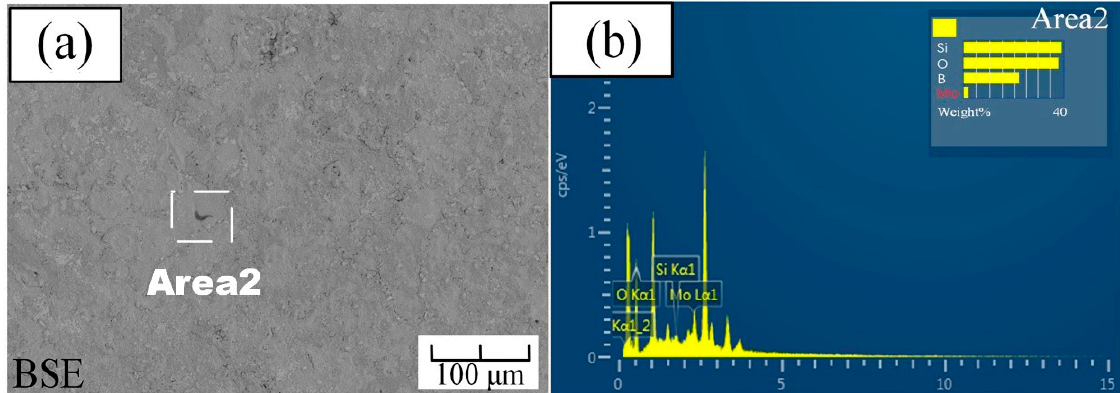
Figure 4. Pre-oxidized surface of the Mo-9Si-8B alloy for 2 h: ( a ) backscattered electron image; ( b ) EDS of Area 2 in ( a ).